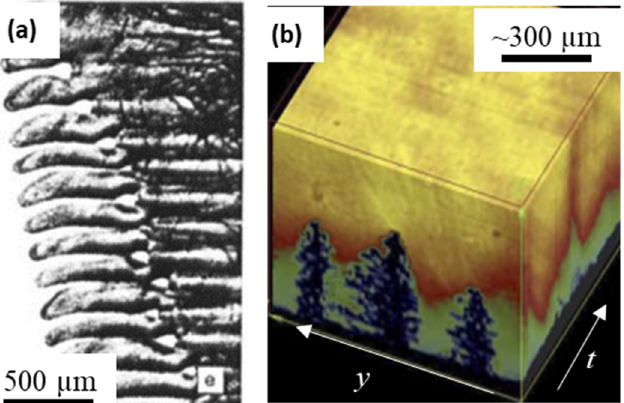
Figure 4. Early in situ synchrotron experiments of solidification: ( a ) white-beam X-ray topographic view showing melt growth of Al-Cu alloy (after Grange et al., [93]); ( b ) Mushy zone and liquid volume contours (y,z,t) showing compositional distribution during solidification of Al-30 wt%Cu alloy (after Mathiessen et al., [96]). Permitted for reuse from respective publishers.